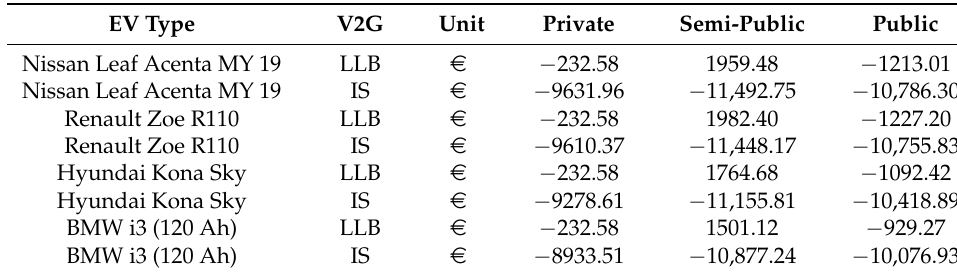
Table 11. V2G impact in EURO of different charging cases (source: own compilation).